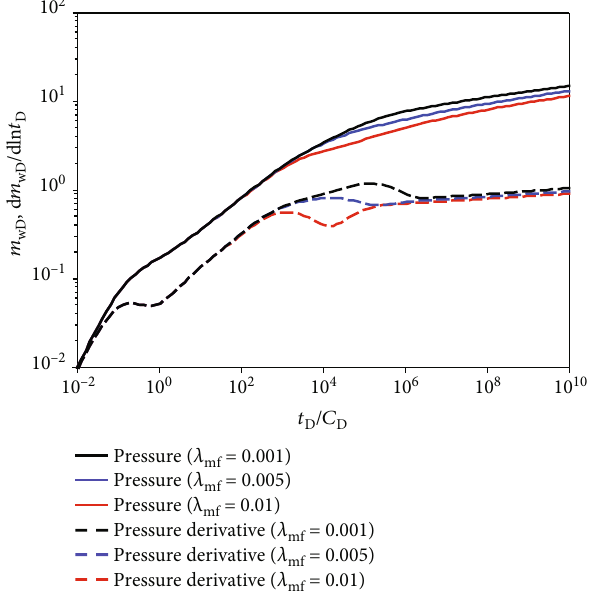
Figure 8: E ff ect of the interporosity fl ow factor, λ